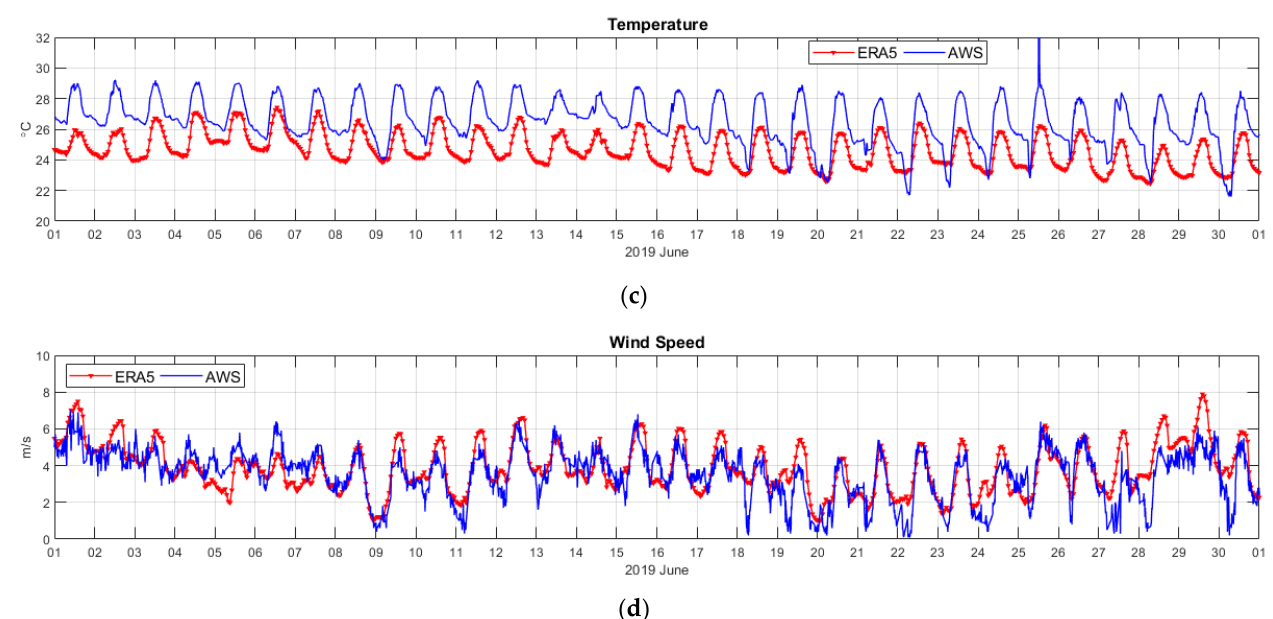
Figure 4. Comparison of weather data from ERA5-ECMWF (red line with triangle) and Automatic Weather Station or AWS (blue line) for: ( a ) Rainfall Rate; ( b ) Solar Radiation; ( c ) Temperature; ( d ) Wind speed.